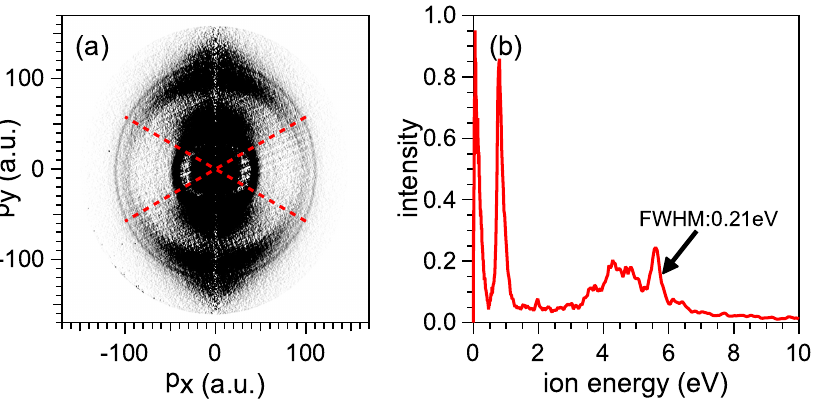
Figure 6. ( a ) The slice of 2D momentum (at p z = 0) through 3D momentum distribution after a Abel inversion from the raw image of Figure 5a. ( b ) The kinetic energy spectrum of O + obtained by integration of the momentum distribution over the polar angle ranges between 60 ◦ and 120 ◦ with respect to the laser